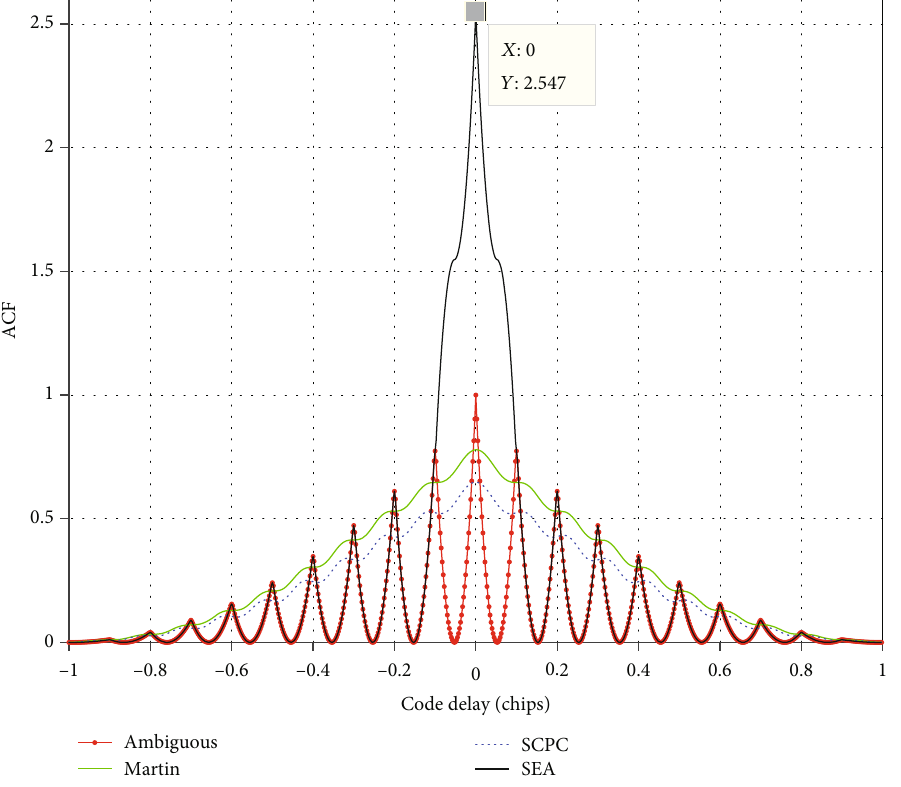
Figure 12: ACF of four